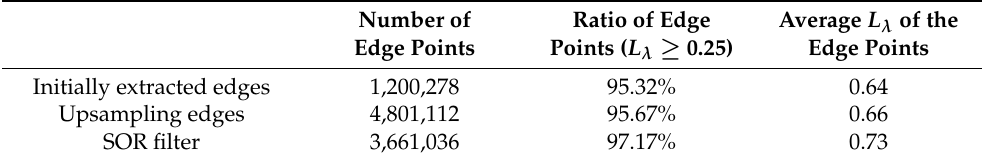
Table 6. Quantitative evaluation of the effects of the SOR